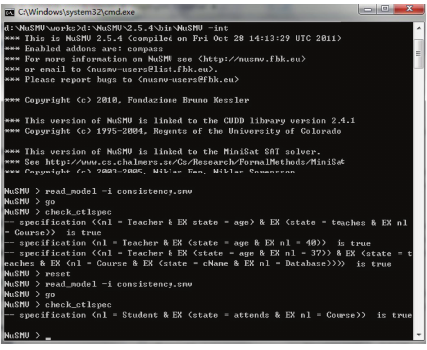
Figure 8: Experiment